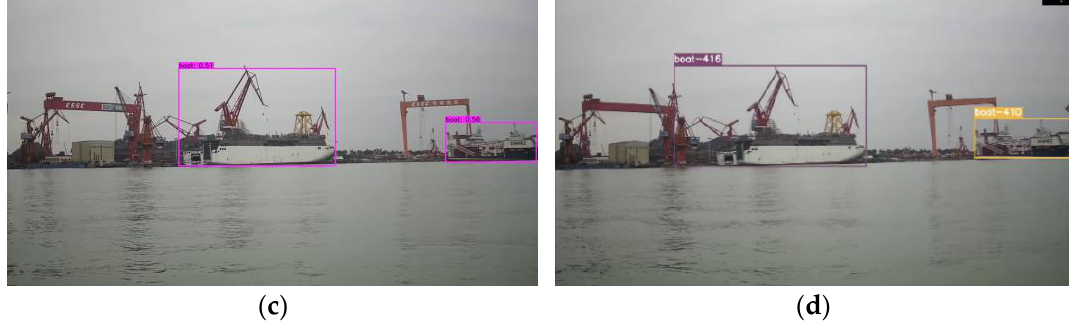
Figure 15. Target detection and tracking result 1 of improved YOLOv4 and UKF algorithm. ( a ) Multi-ship target detection in video. ( b ) Multi-ship target tracking in video. ( c ) Multi-ship target detection with shore background interference in video. ( d ) Multi-ship target tracking with shore background interference in video.